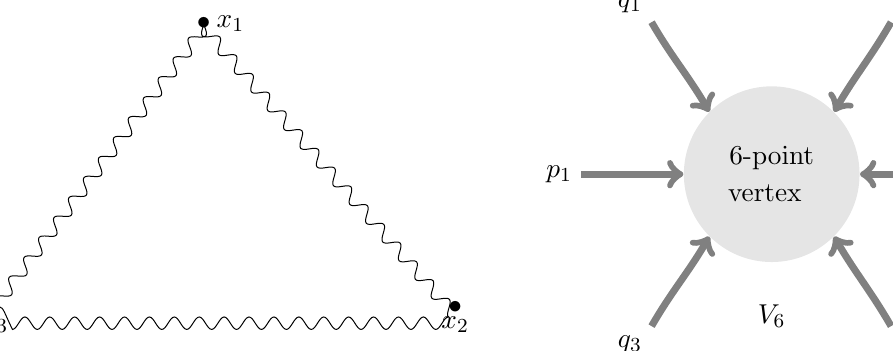
Figure 6a. Tree-level diagram in the e(cid:11)ective theory without interacting vertexes.